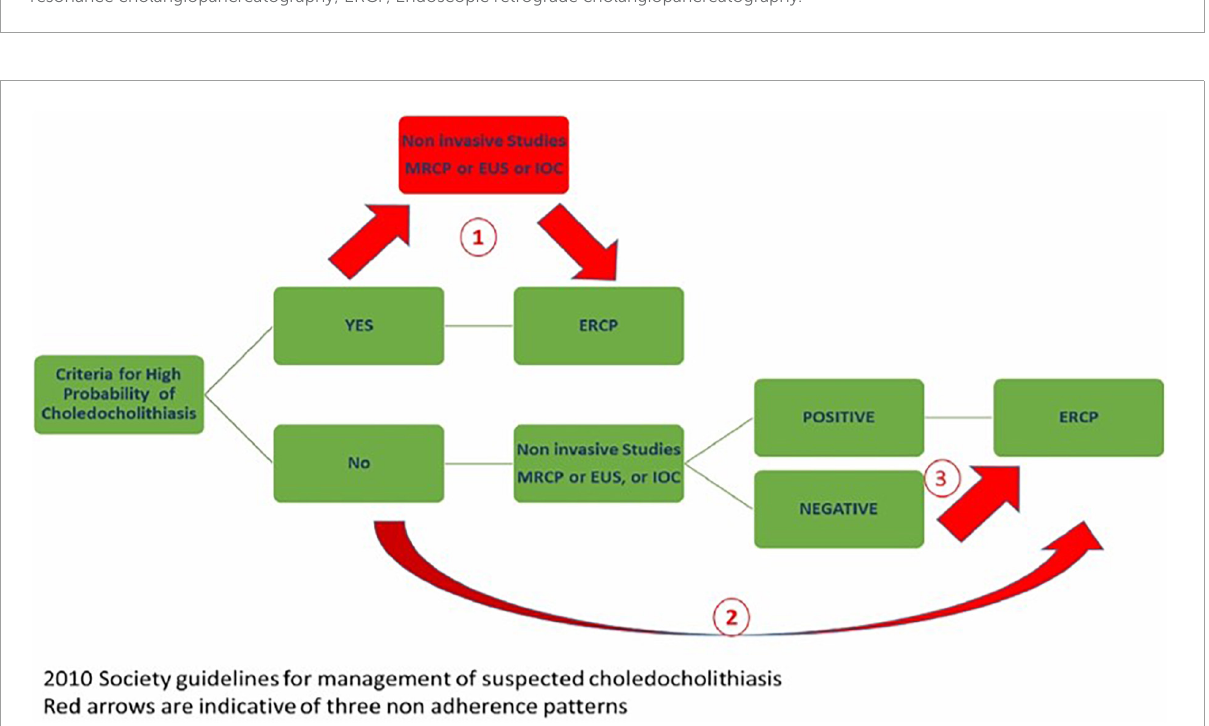
FIGURE2 Choledocholithiasis management algorithm based on the 2010 ASGE practice guidelines with three non-adherence pathways causing delay in care, potential harm, and significant harm.